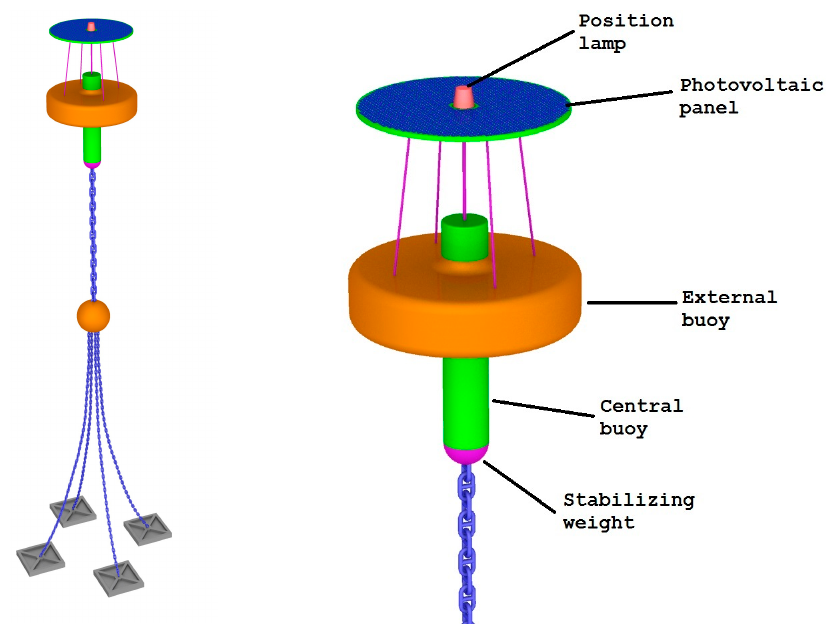
Figure 6. Model design of the wave energy converter.